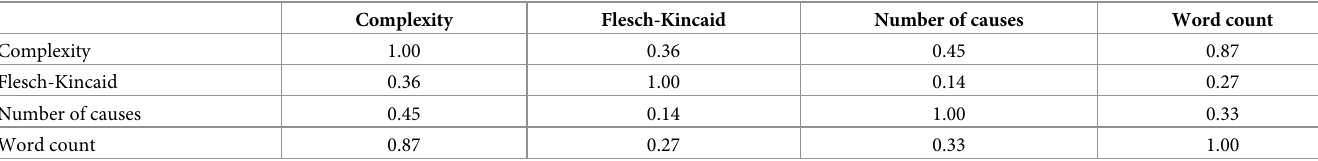
Table 2. Correlations between dependent measures.